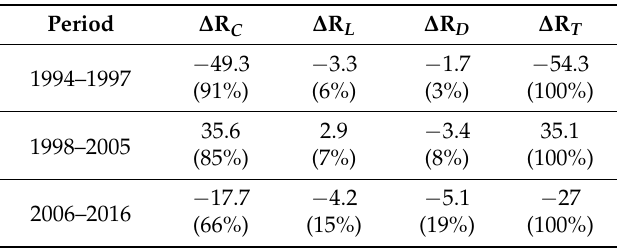
Table 6. Results of multi-stage method (unit: km 3 ).